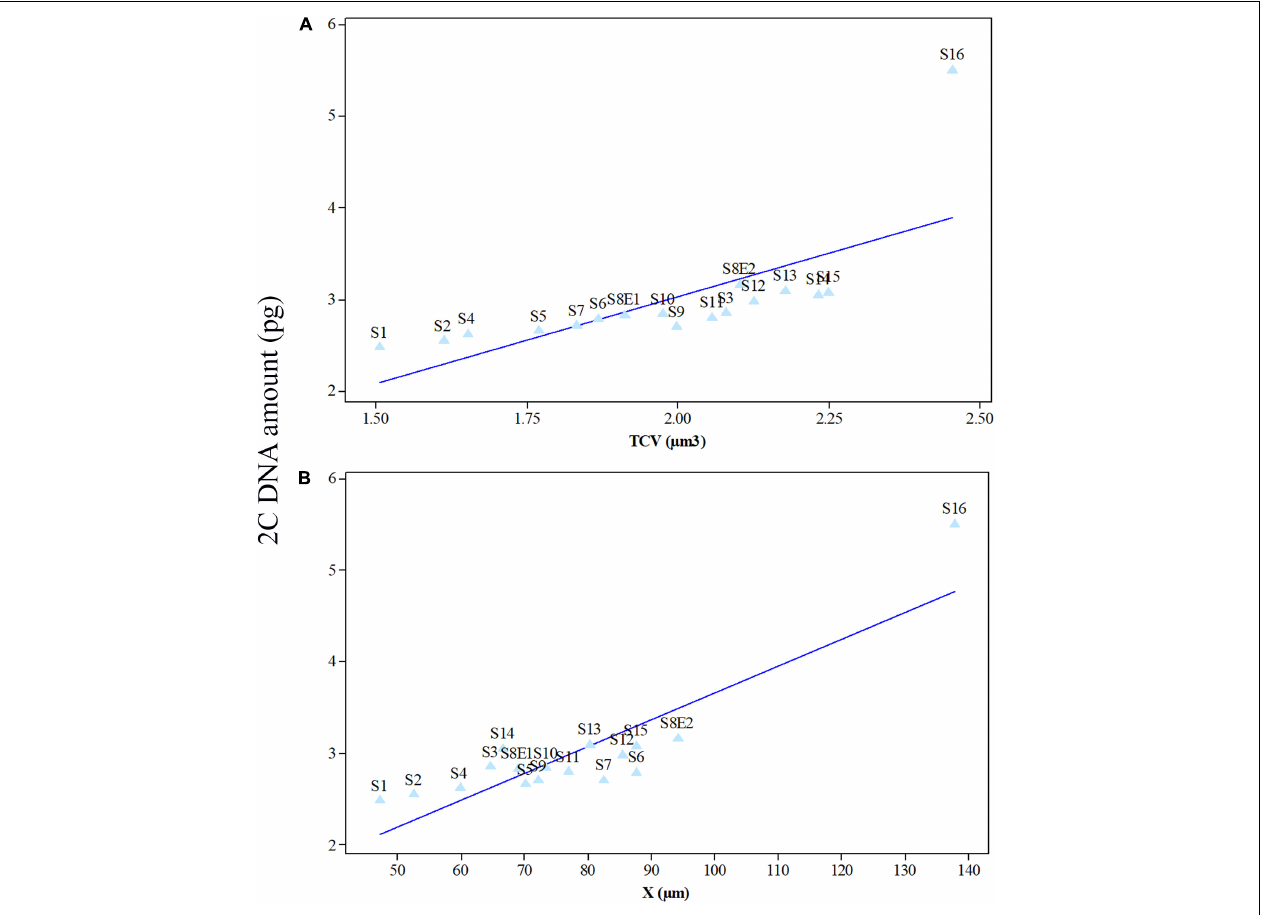
FIGURE 7 | Mean leaf 2C DNA amounts (pg) of 17 Pimpinella populations of 16 species plotted against mean meristem total chromosome volumes (TCV, µ m 3 ) (A) and chromatin lengths (X, µ m) (B) at mitotic metaphase. S1 ( P. affinis ), S2 ( P. eriocarpa ), S3 ( P. tragium ), S4 ( P. saxifrage ), S5 ( P. aurea ), S6 ( P. tragioides ), S7 ( P. olivieri ), S8 ( P. khayyamii ), S9 ( P. kotschyana ), S10 ( P. deverroides ), S11 ( P. olivierioides ), S12 ( P. anthriscoides ), S13 ( P. anisactis ), S14 ( P. peucedanifolia ), S15 ( P. khorasanica ), and S16 ( P. rhodantha